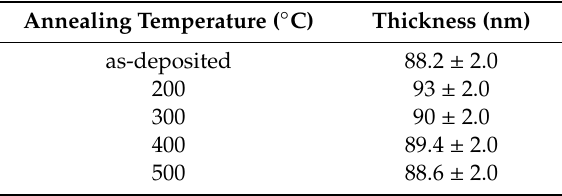
Table 1. E ff ects of annealing temperature on thickness of Ti:SnO 2 films.